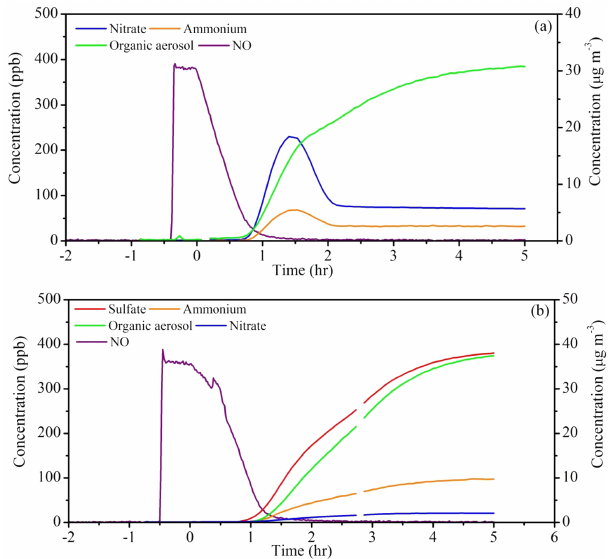
Figure 4. Concentration–time plots of NO (left y axis) and particle- phase species (right y axis) during the photochemical aging of emis- sions from vehicle II. (a) Without SO 2 , and (b) with SO 2 . The concentrations of particle-phase species are wall-loss-corrected. At time = 0h, the black lamps were turned